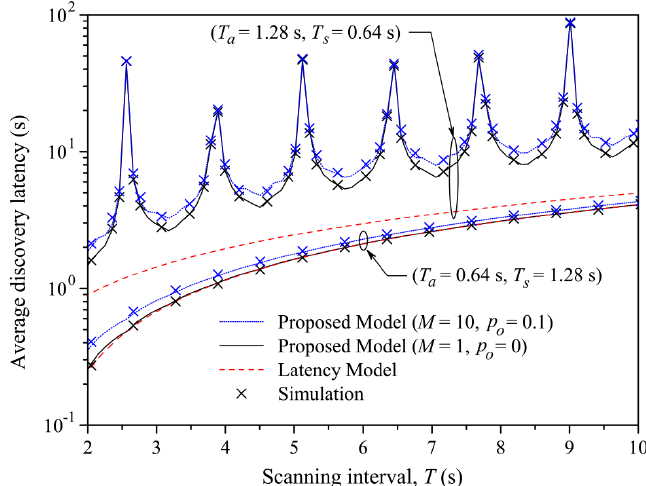
Figure 23. Average discovery latency of the advertiser according to different values of Scan Interval . Blue and black curves indicate the theoretical model and the simulation proposed in [78], while the red lines represent the latency model of [79]. M is the number of pairs of scanners and advertisers , which can communicate with each other, while p 0 is the failure probability due to the interference with other devices. Adapted from